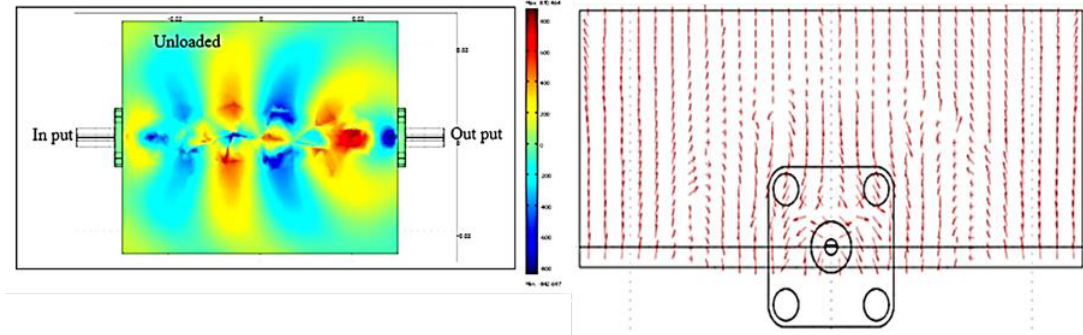
Figure 10. Electric field distribution and intensity plot for the unloaded microstrip.